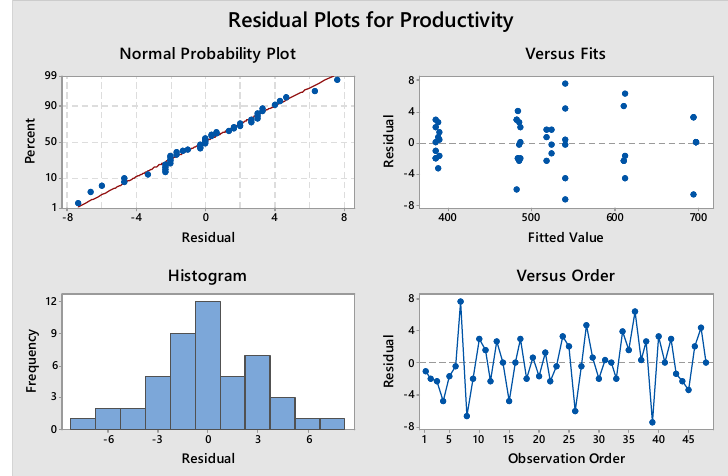
Figure 8. Residual Plots for Productivity.